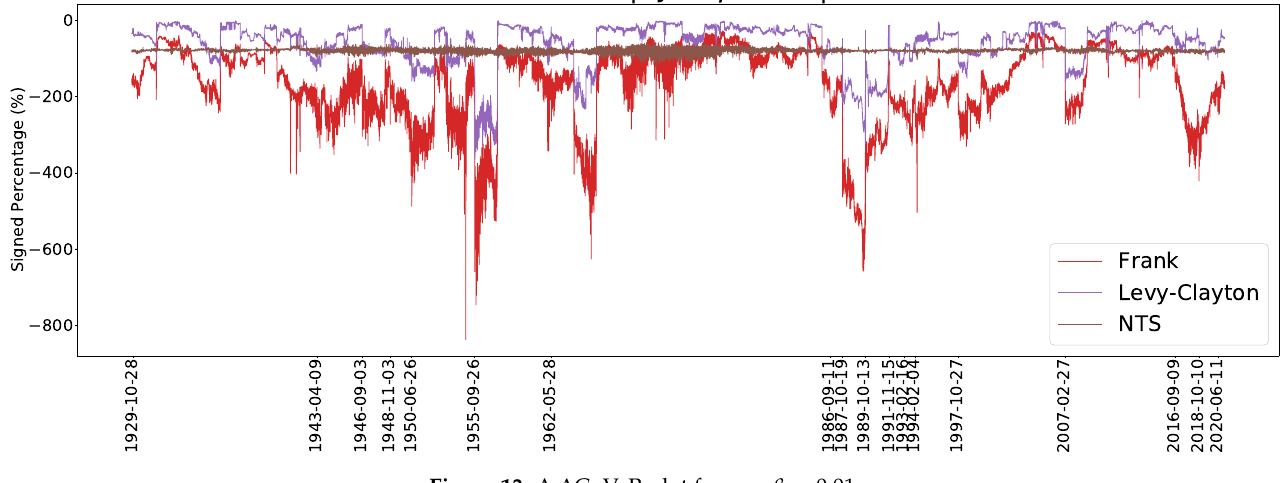
Figure 13. A ∆ CoVaR plot for α = β = 0.01.